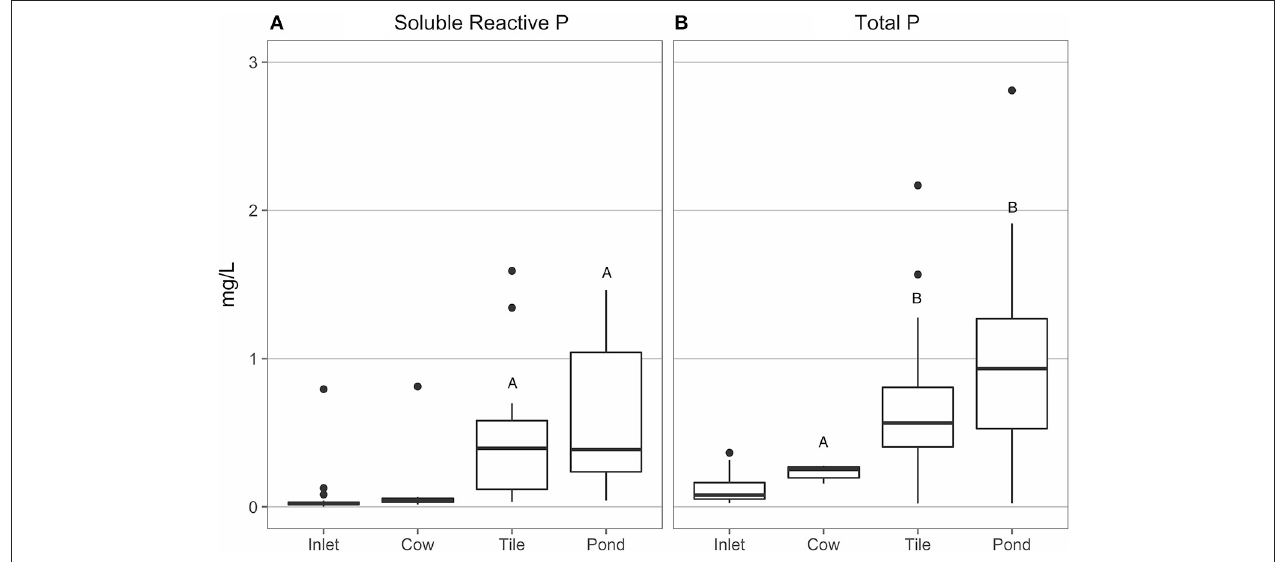
FIGURE 6 | Post-BMP SRP (A) and TP (B) concentrations from point sources along the stream reach. Statistical difference is noted by “A’ and “B” above (all TP data p -values < 0.01). Point sources came from pond effluent (Pond, n = 29), a tile drain (Tile, n = 27), and a cow-generated saturated area (Cow, n = 8). Inlet is included for reference ( n = 24).